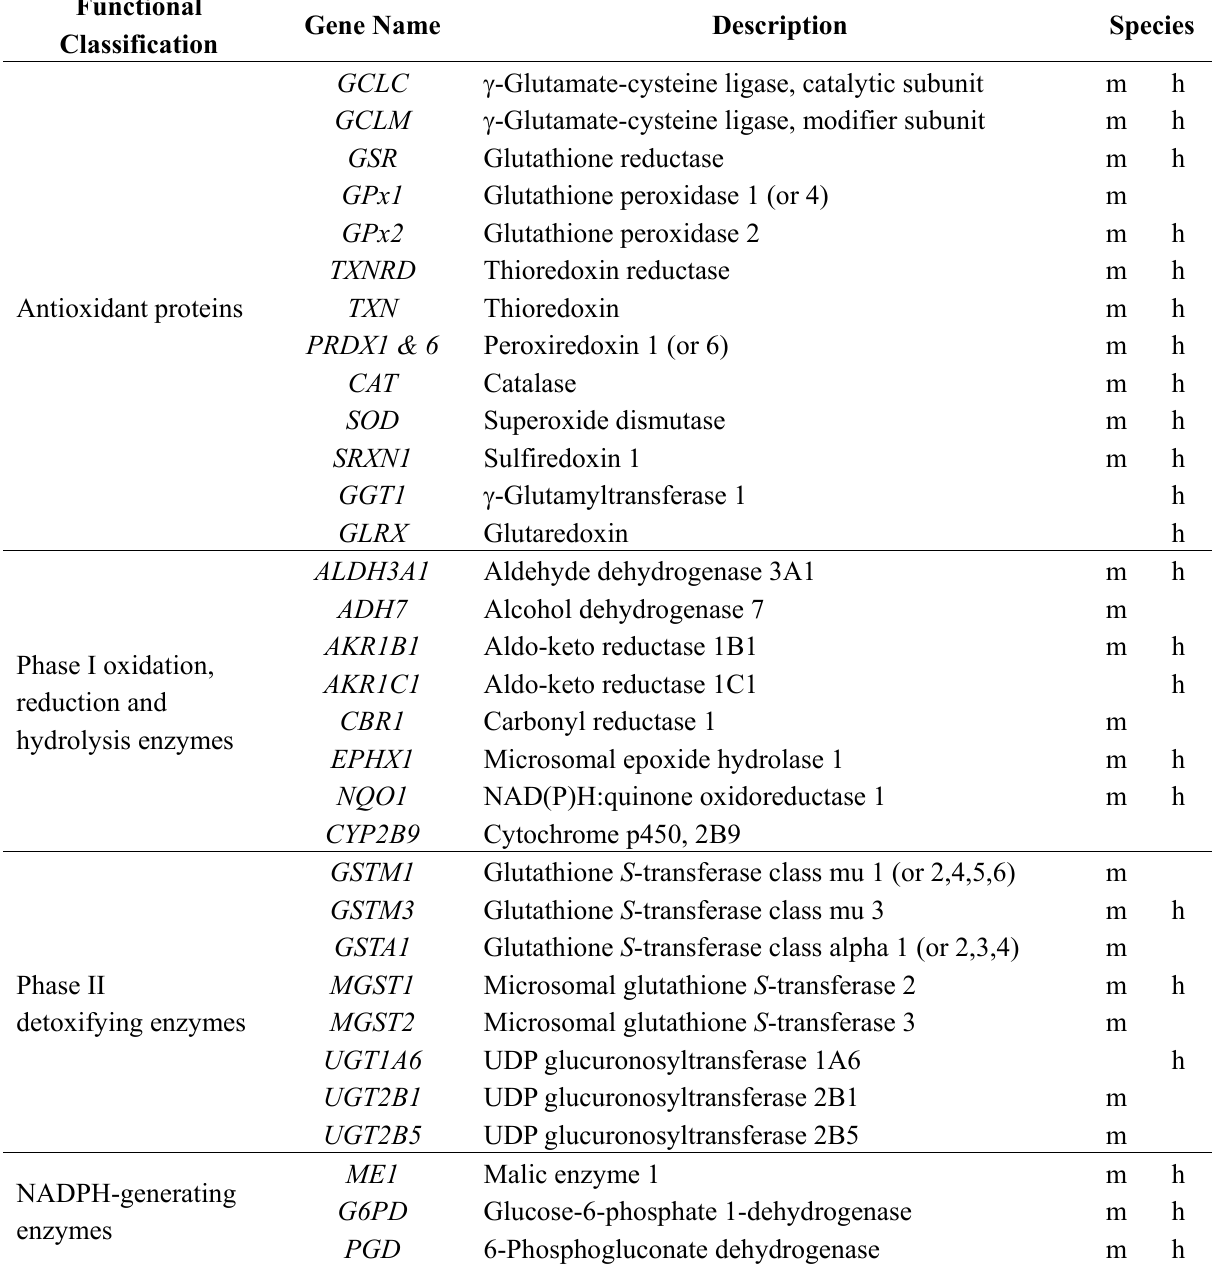
Table 2. Genes regulated by NRF2 in mouse (m) and human